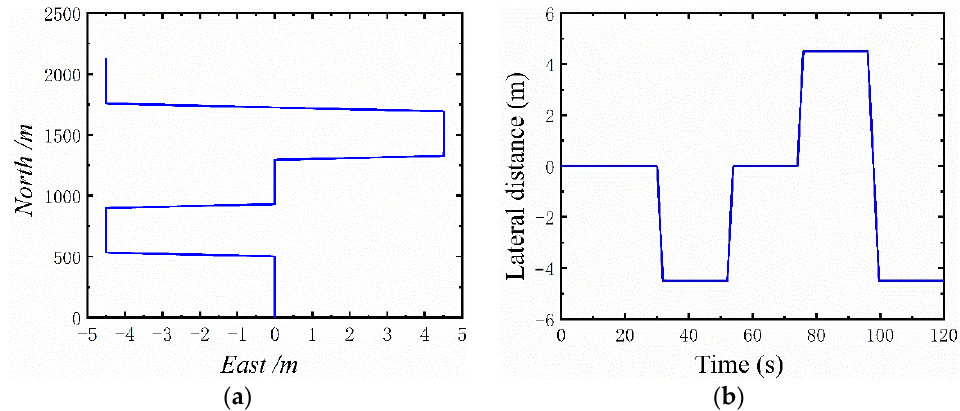
Figure 9. Vehicle track information image: ( a ) Vehicle track information; ( b ) Lateral distance variation of the vehicle.